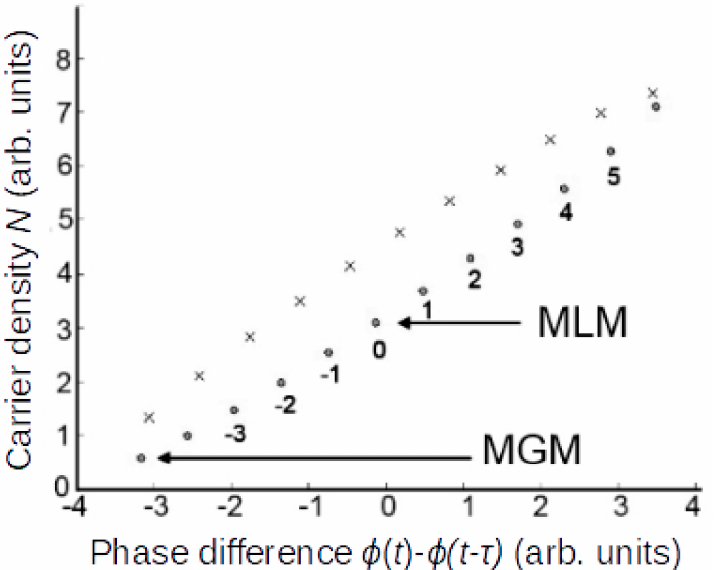
Figure 2. Locations of the equilibria (ECMs) (circles) and antimodes (crosses) in the ( N ( t ), φ ( t ) − φ ( t − τ )) plane according to the Lang and Kobayashi (LK)